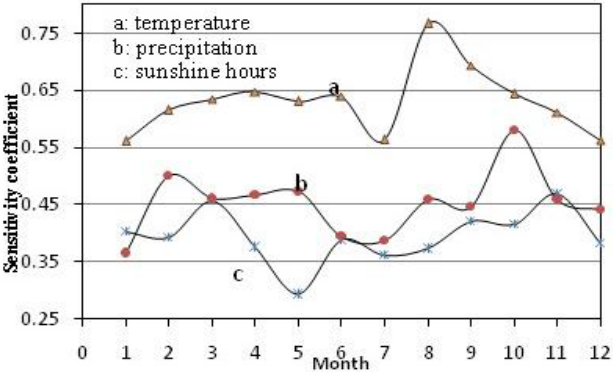
Figure 12. Sensitivity coefficient of precipitation, temperature, and sunshine hours (from 2001 to 2011).